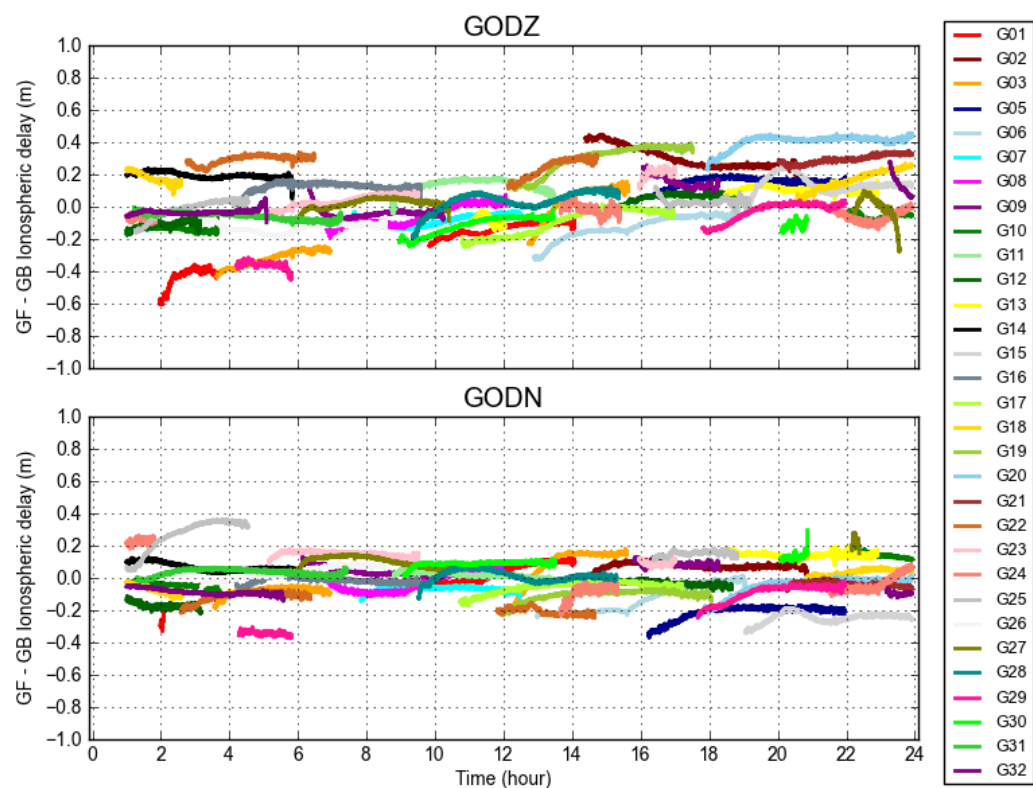
Figure 4. Differences of GF filtered and GB ionospheric delays for all of the observed satellites computed for GODZ ( top ) and GODN ( bottom ) observations, and the ESA final OC products. The distance between GODZ and GODN is about 65.16 m.